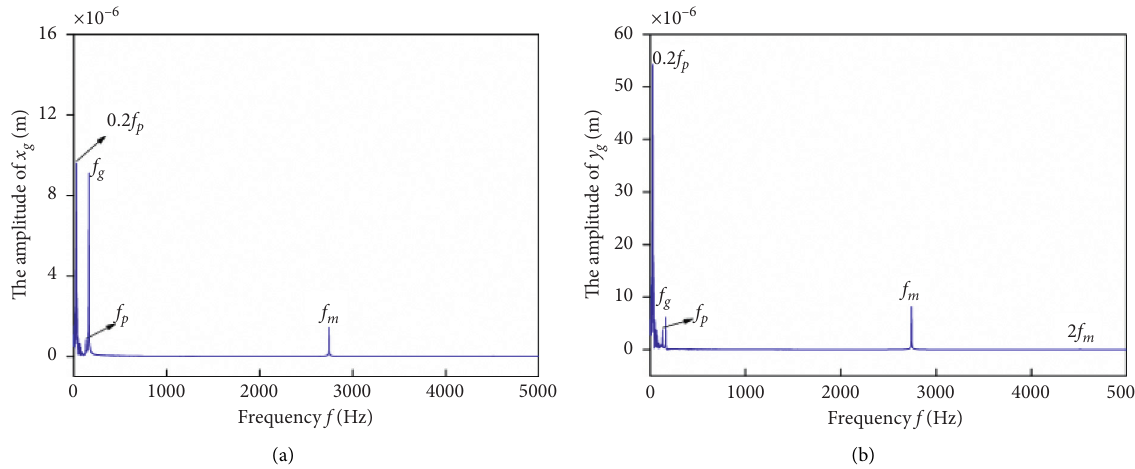
Figure 15: The frequency-domain responses of driven gear at i � 1.25: (a) in x direction and (b) in y